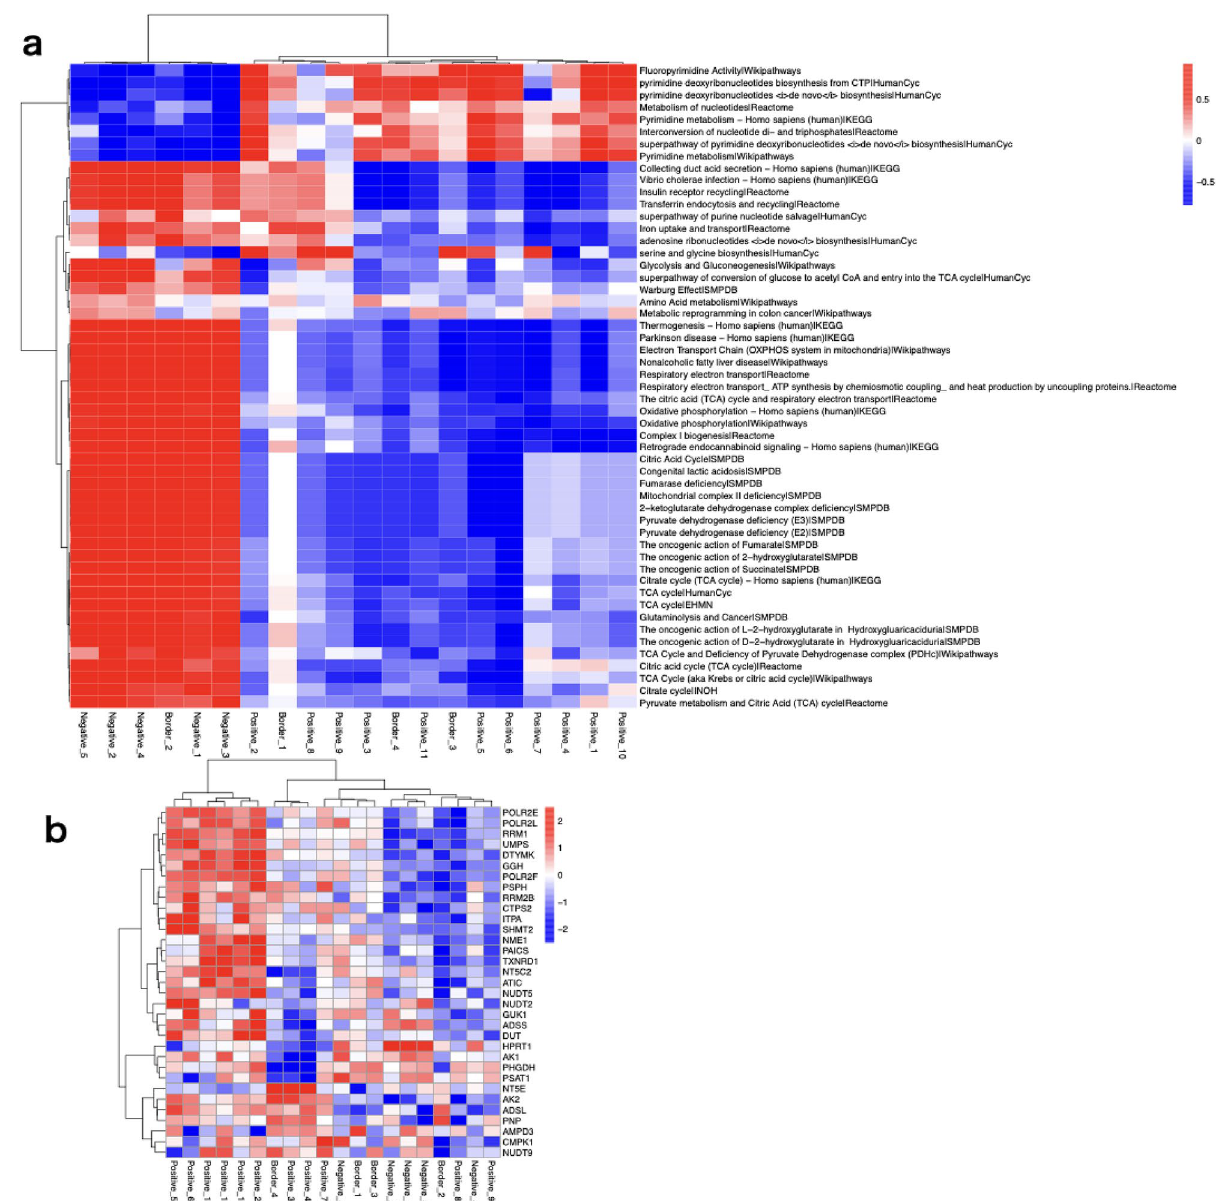
Figure 3. ( a ) Heatmap of the enrichment score matrix for 20 tissues and 53 metabolic pathways with fewer than 300 genes and p-values of less than 10 −4 in pathway over-representation analysis (R package pheatmap version 1.0.12). The color intensity indicates the level of enrichment score of each pathway which was calculated by gene set variation analysis. ( b ) Heat map of the 33 enzymes in the enriched metabolic pathway. The color intensity indicates the expression level of each